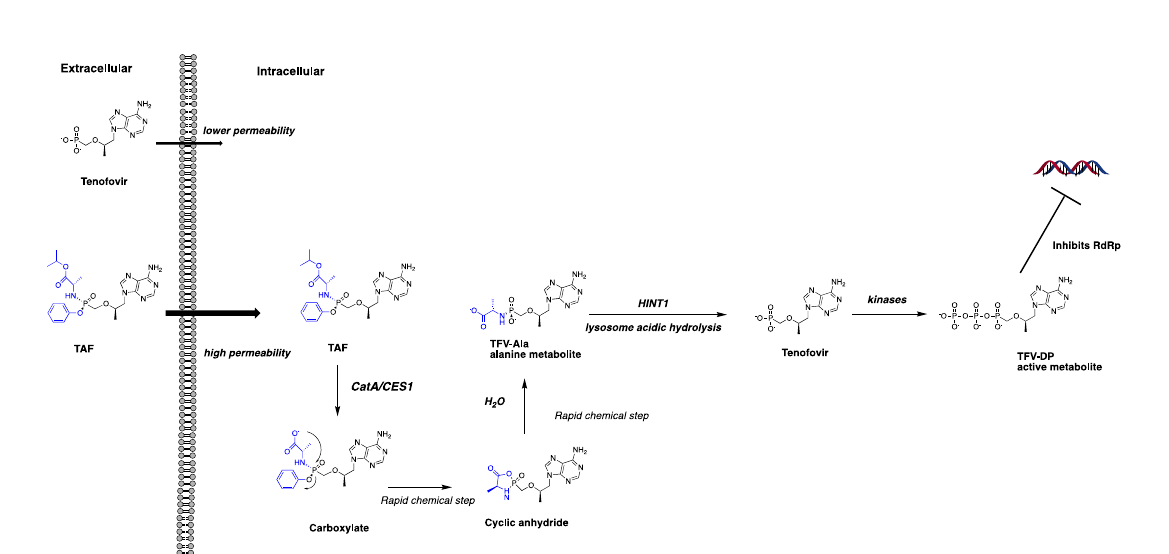
Figure 1. Chemical structures of the three FDA-approved antiviral ProTides, tenofovir alafenamide (TAF), sofosbuvir (SBV), and remdesivir (RDV). Two oxygens of monophosphate/monophospho- nate are masked by an aryloxy group and an amino acid ester group (highlighted in blue).